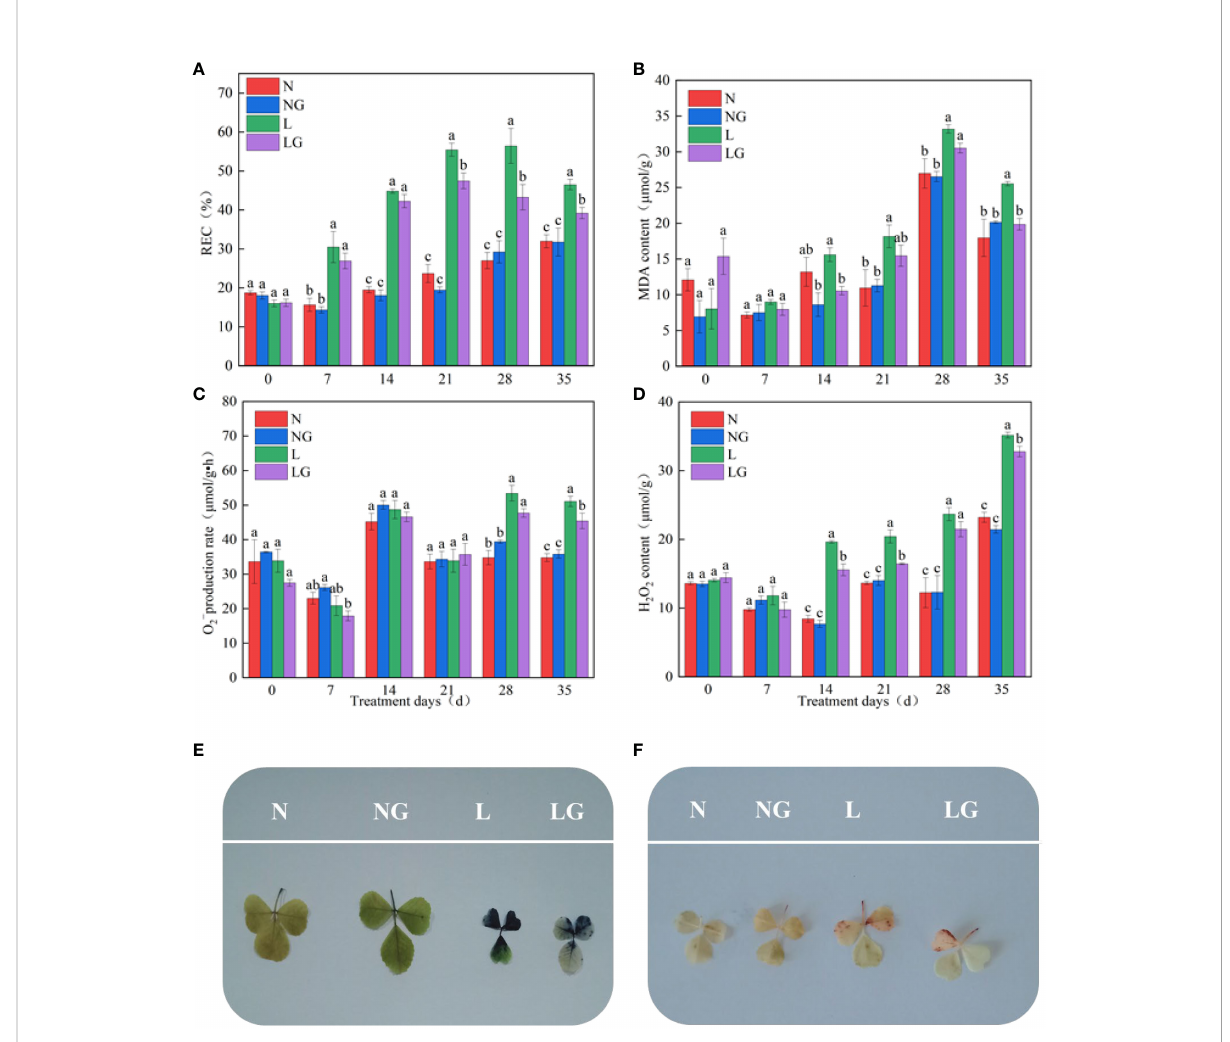
FIGURE 3 Effect of GABA spraying on oxidative damage parameters in M. ruthenica seedlings on different treatment days. (A) Relative electric conductivity (REC) content in leaves; (B) malondialdehyde (MDA) content in leaves; (C) superoxide anion (O − 2 ) generation rate in leaves; (D) hydrogen peroxide (H 2 O 2 ) content in leaves; (E) visualization results of superoxide anion (O − 2 ); (F) visualization results of hydrogen peroxide (H 2 O 2 ). N, the plant pretreated with distilled water and grown at normal temperature. NG, the plant pretreated with GABA and grown at normal temperature.